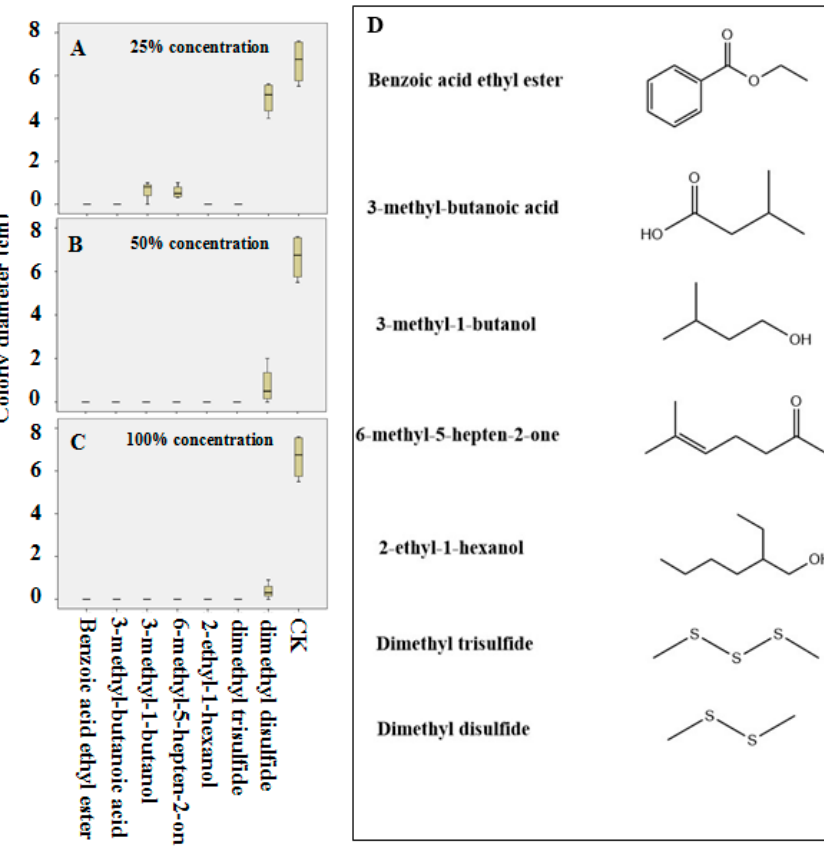
µ L pure substances and 150